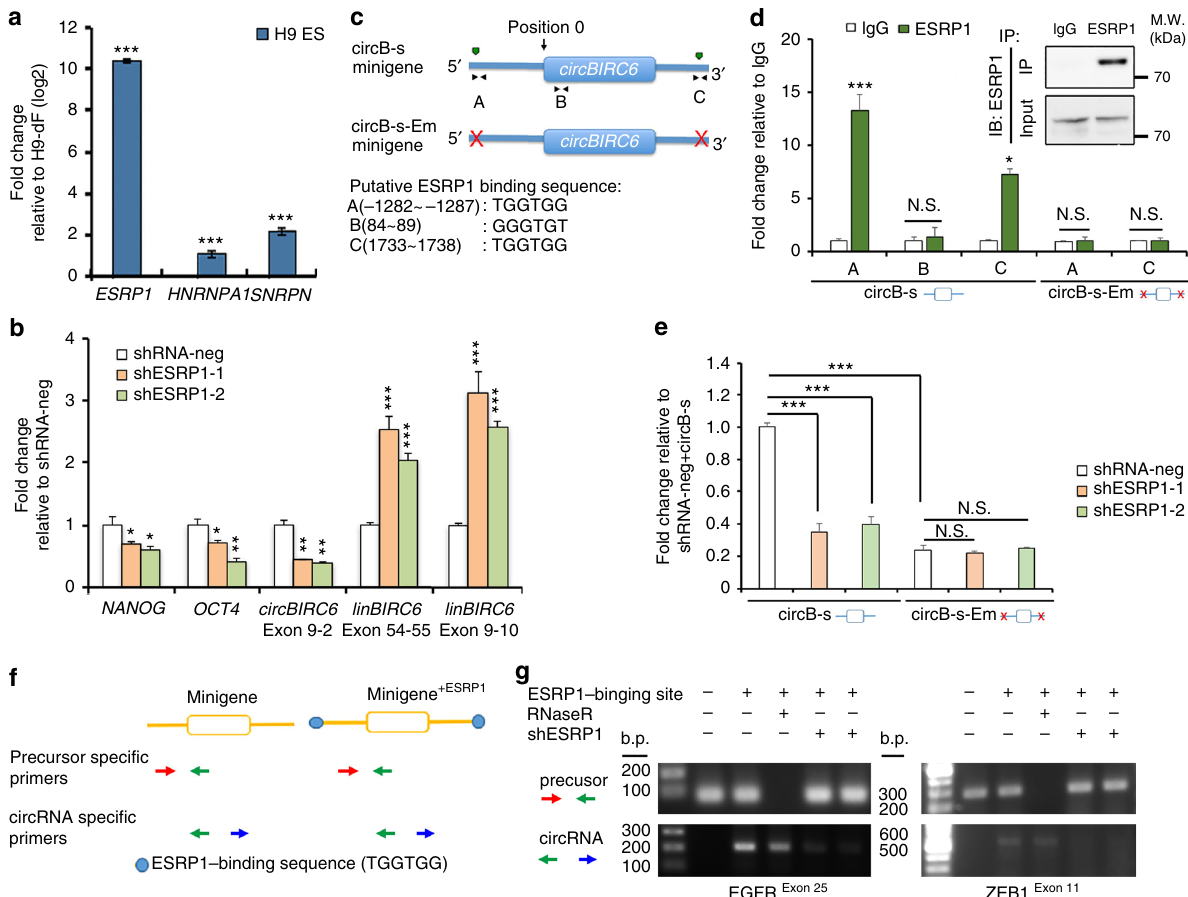
Fig. 7 ESRP1 promotes the biogenesis of circ BIRC6 in hESCs. a RT-qPCR analysis of the splicing factors (as indicated) in H9 hESCs. b RT-qPCR analysis of the expression of circBIRC6 (exon 9 – 2), linear BIRC6 (linBIRC6 exon 9 – 10 and exon 54 – 55), NANOG , and OCT4 in ESRP1-knockdown hESCs (shESRP-1 and shESRP-2). c Schematic illustrating the putative ESRP1-binding sites on the fl anking introns in the circB-s minigene. The 5 ′ terminus of the circular exons of circBIRC6 was de fi ned as position 0. Putative ESRP1-binding sites A, B, and C are located in the intron at the 5 ′ terminus of the circBIRC6 exon (position: − 1282 to − 1287), within the circBIRC6 exon (position: 84 – 89), and on the intron at the 3 ′ terminus of the circBIRC6 exon (position: 1733 – 1738). d RIP analysis of ESRP1-binding to circB-s and circB-s-Em minigenes in hESCs. Bound complexes were pulled-down using an antibody against ESRP1. RT-qPCR was then used to measure circB-s binding to ESRP1. Values were normalized to the level of background RIP, as detected by an IgG isotype control. Inserted panel: Immunoblotting (IB) of immunoprecipitated (IP) ESRP1 protein. e RT-qPCR analysis of the expression of circBIRC6 relative to GAPDH in hESCs. Cells were co-transfected with shRNA that target ESRP1 and a circBIRC6 minigene (circB-s), or circBIRC6 minigene containing deleted ESRP1-binding sites (circB- s-Em). f Schematic showing sites of insertion of ESRP1-binding sequence and the location of primers used for detecting the two minigenes (EGFR and ZEB1). g RT-PCR analysis using circRNA-speci fi c or precursor speci fi c primers on RNA from hESCs that were transfected with the indicated minigenes, with or without shRNA-mediated disruption of ESRP1. Quantitative data from three independent experiments is presented as mean ± SD (error bars). P -values were determined by two-tailed two-sample t -tests (* P < 0.05; ** P < 0.01; *** P <